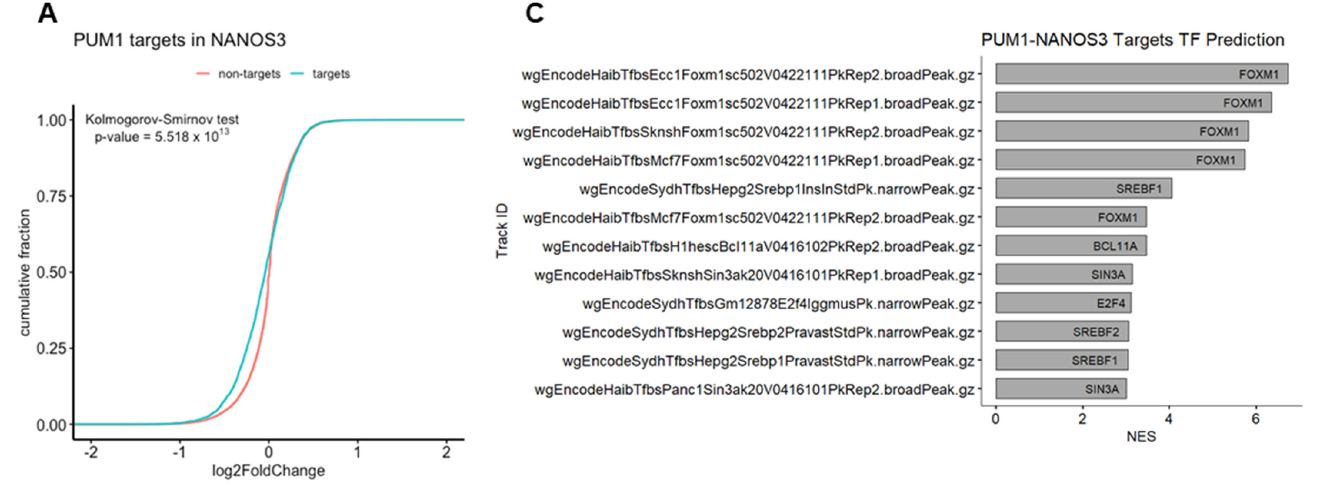
Figure 4. FOXM1 and TAF1 act as transcription factors for NANOS1 and NANOS3 downregulated genes. ( A ) Cumulative distribution analysis of differentially expressed genes upon NANOS3 RNA- Seq. Common differentially expressed mRNA distribution shown in blue and labeled as targets. The rest of the differentially expressed genes are shown in red and labeled as non-targets. ( B ) Common differentially expressed genes that are repressed by both NANOS3 and PUM1 identified as down- regulated (log2FC < 0) upon NANOS3 overexpression and upregulated (log2FC > 0) upon PUM1 knockdown. ( C ) iRegulon transcription factor prediction analysis for NANOS3/PUM1 common re- pressed genes. ( D ) Cell cycle related biological processes identified by gene ontology enrichment analysis for NANOS3-PUM1 common repressed genes. 2.6. FOXM1 Is a Post-Transcriptional Target for NANOS3/PUM1 Complex Since NANOS3 and PUM1 potentially cooperate for mRNA repression in the TCam- 2 cell line, we asked whether these two proteins also interact and form a protein complex. For this purpose, we performed pulldown experiments in which we overexpressed PUM1-FLAG and NANOS3-GST in the TCam-2 cell line in the presence and absence of RNAse A. This experiment showed that indeed NANOS3 and PUM1 can form a complex in the TCam-2 cell line. The lack of RNA weakened this interaction drastically (Figure 5A), suggesting that the presence of RNA potentially stabilizes NANOS3–PUM1 interaction. Next, we have investigated whether FOXM1 mRNA is a NANOS3/PUM1 target. Since NANOS/PUM RNP complexes function by binding to the specific PBE motif (UGUA- HAUA) in the 3 ′ UTR of target mRNAs followed by repression, we screened the 3 ′ UTR of FOXM1 mRNA and identified one PBE and two PBE-like (containing UGUA core) motifs